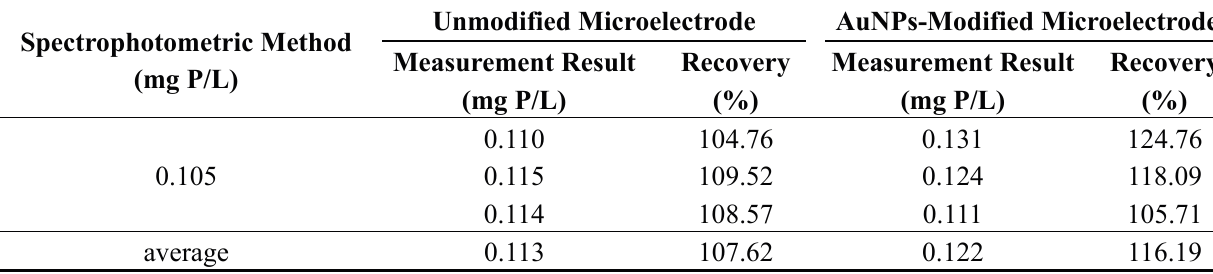
Table 2. The measurement results of a real